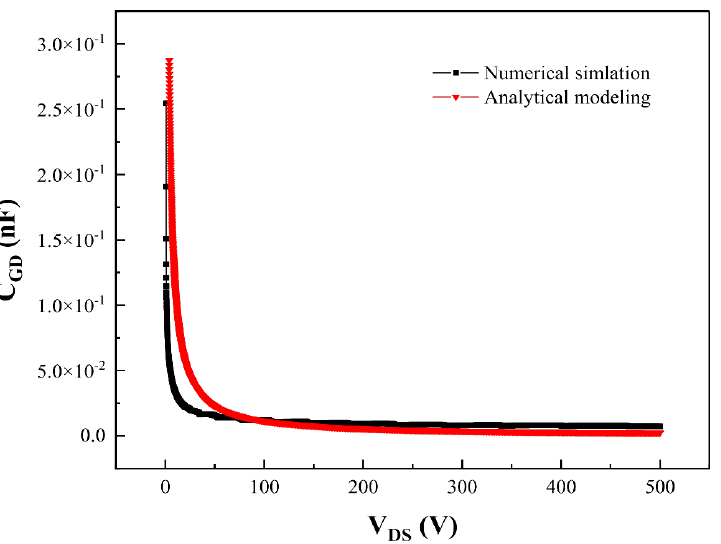
Figure 6. The reverse transfer capacitance of analytical modelling and numerical TCAD simulation as the drain voltage.